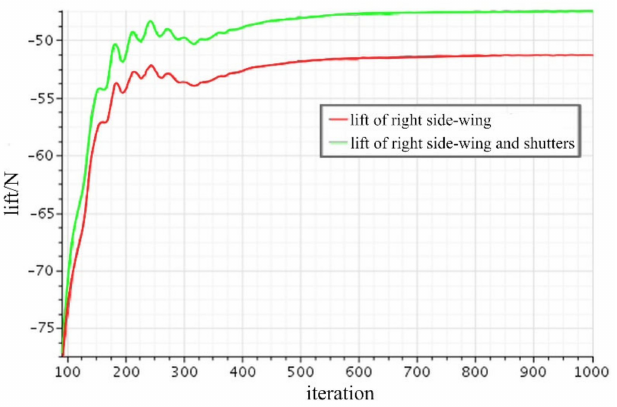
Figure 11. Convergence of lift results on a side wing only compared with a side wing and